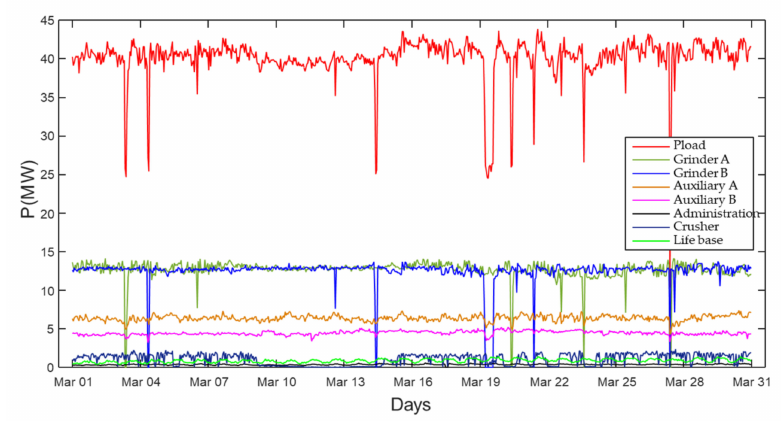
Figure 6. Mine load profile for the month of March